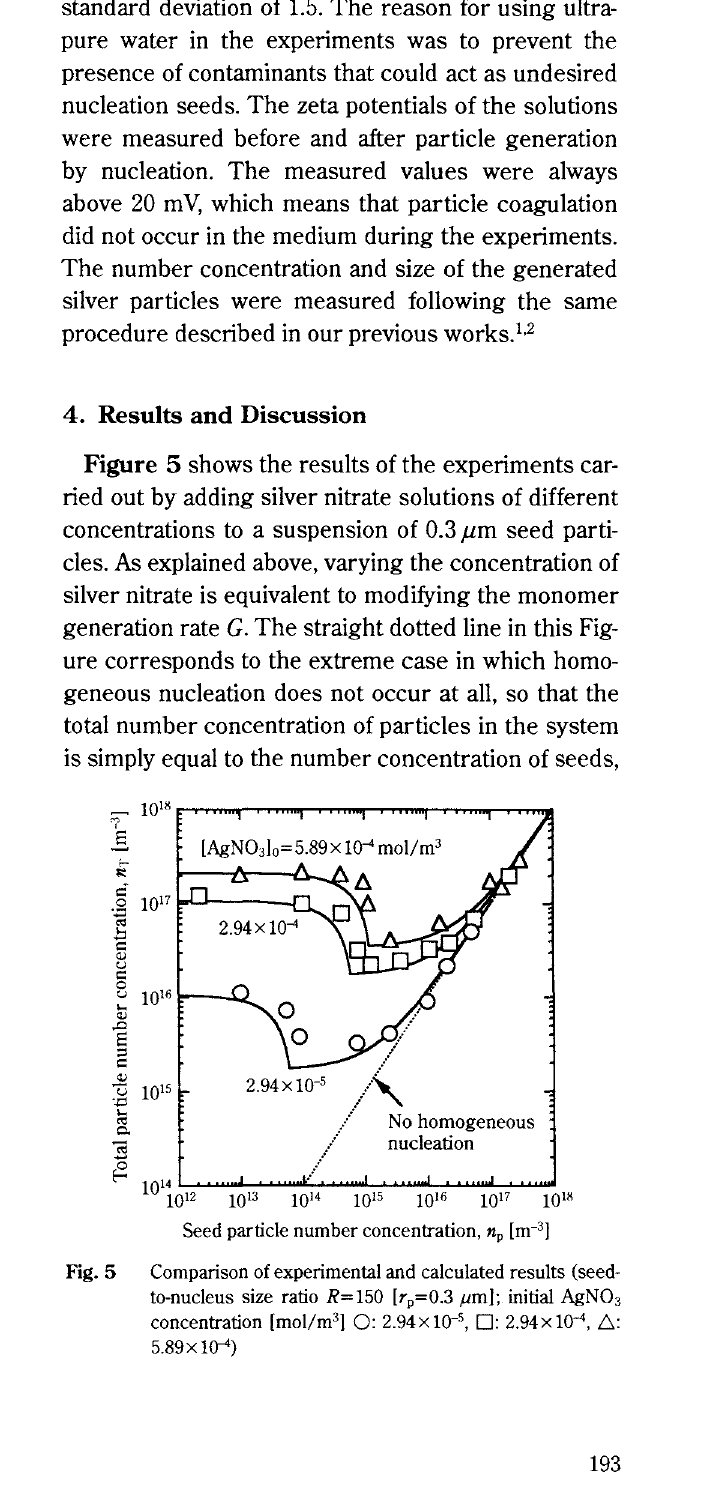
Effect of the seed-to-nucleus size ratio R on the relative importance of homogeneous and heterogeneous nucleation